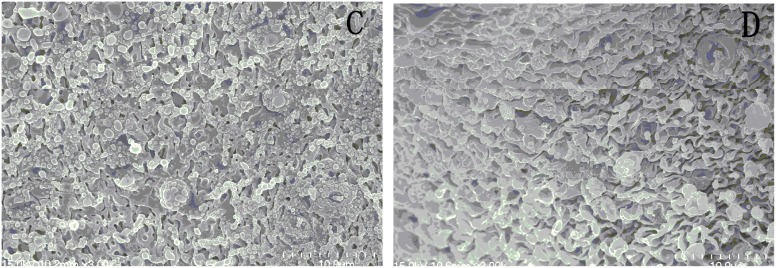
Scanning electron microscopy (SEM, ×3000) observation on male adult Schistosoma japonicum collected from mice 24 h after administration of DW-3-15 (200 mg/kg).C: The mid-region of body wall. D: The inner wall of the worm gynecophoral canal.